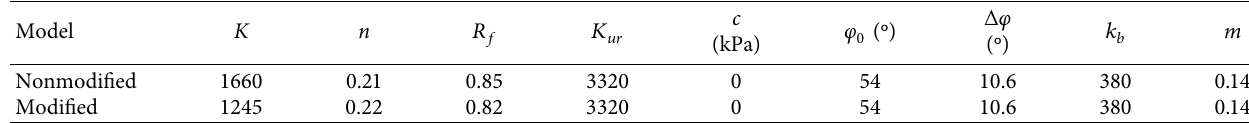
Table 12: Parameters of the E - B model.